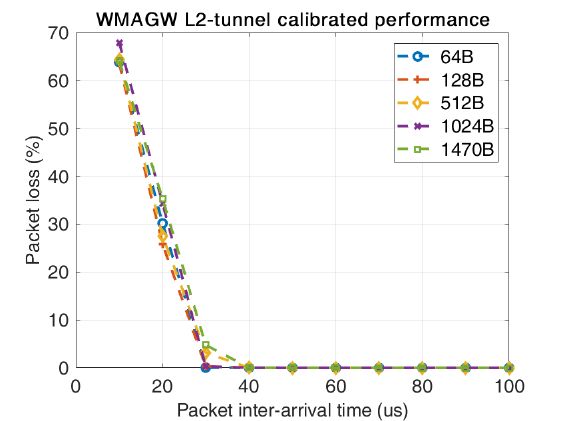
Figure 8. PER statistics for different combinations of packet size and PIAT when transmitted between two WMAGW in L2-tunneling operational